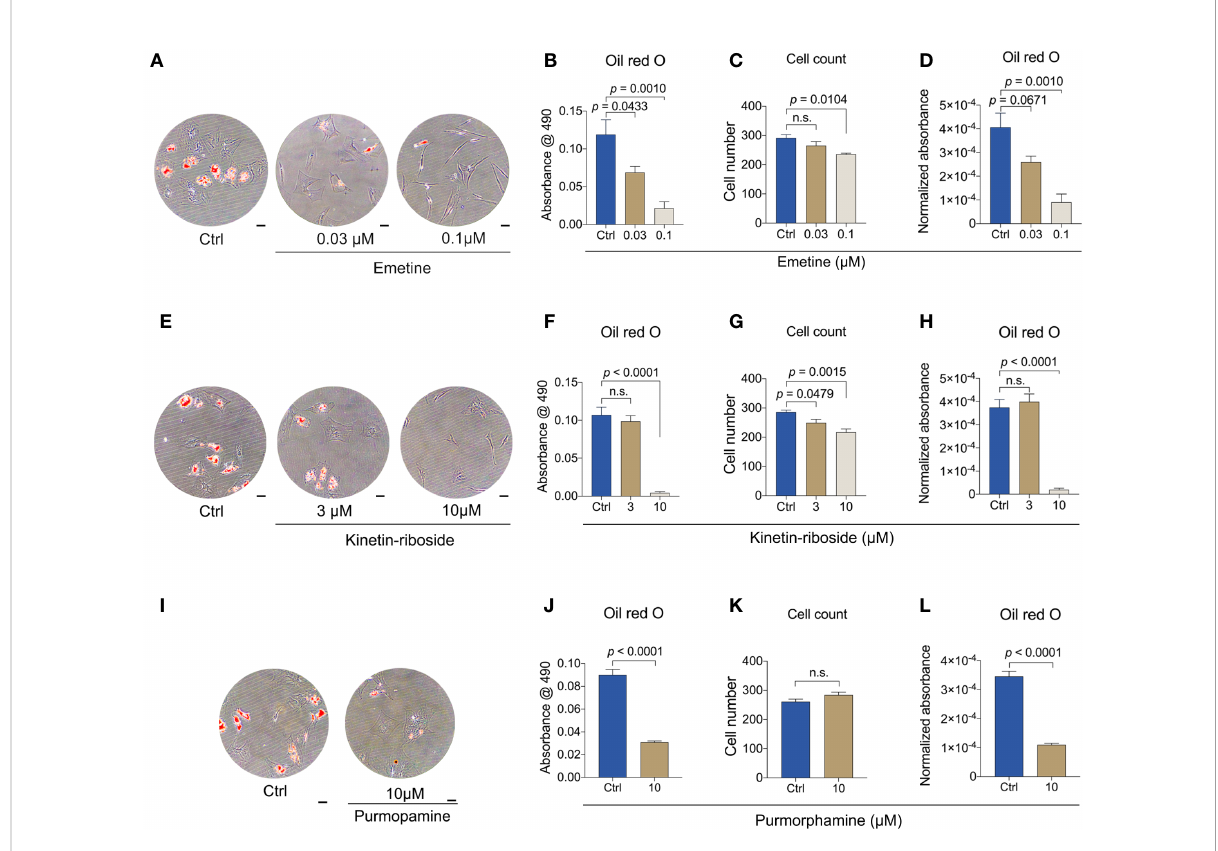
FIGURE 6 Emetin, kinetin-riboside and purmorphamine are anti-adipogenic. (A-D) Representative images (A) and quantitative data (B-D) of Oil Red O staining. Oil Red O staining was performed after 14 days of adipogenic differentiation from BMSCs following emetine treatment (B) . Normalized absorbance of Oil Red O (D) was adjusted by cell number (C) . (E-H) Representative images (E) and quantitative data (F-H) of Oil Red O staining as described in (A-D) following treatment of kinetin-riboside using adipogenic-BMSCs. (I-L) Representative images (I) and quantitative data (J-L) of Oil Red O staining as described in (A-D) following treatment of purmorphamine. Scale bars in A, E and I: 50 m